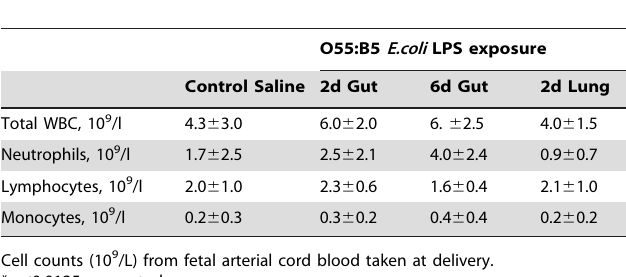
Table 5. Total and differential white blood cell counts.